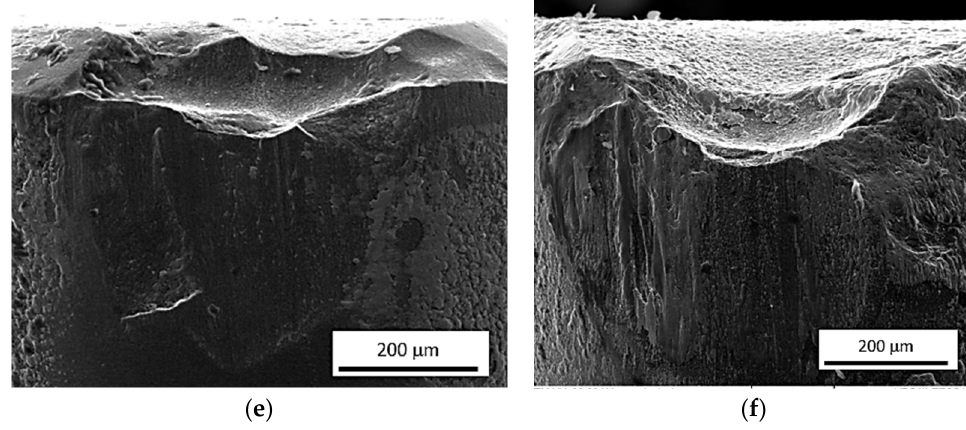
Figure 1. SEM images of worn cutting edges: ( a ) VB = 0 mm; ( b ) VB = 0.1 mm; ( c ) VB = 0.2 mm; ( d ) VB = 0.4 mm; ( e ) VB = 0.6 mm; ( f ) VB = 0.8 mm. The thickness of WL and HAZ was measured on the metallographic images cut along the cutting direction (see Figure 2). Ten-millimetre-long pieces were cut off, hot moulded, ground, polished, and Nital etched (5% Nital concentration for 10 s). The hot moulded specimens produced by the insert of VB = 0.8 mm were, after metallographic observation, also employed for microhardness measurements HV0.05 . The thicknesses of WL and HAZ for the surfaces produced by the inserts of lower VB were too thin for microhardness measurements. HV0.05 was measured using an Innova Test 400TM (Innovatest, Maastricht, The Netherlands) (load of 50 g for 10 s). The thicknesses of WL, HAZ, and HV0.05 were obtained by averaging 5 repetitive measurements.